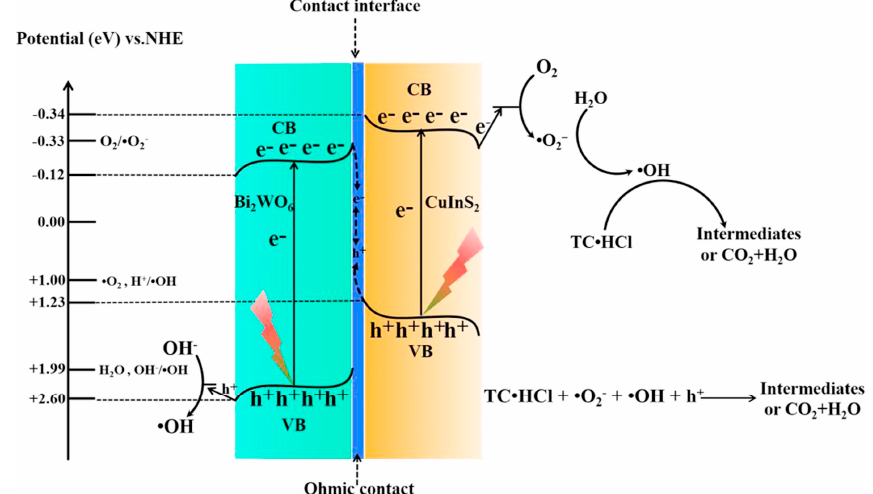
Figure 13. Schematic illustrating the interfacial electron transfer process and possible photocatalytic mechanism of CuInS 2 /Bi 2 WO 6 with the Z-scheme heterojunction. Adapted with permission from Reference [77]. Copyright (2019) Elsevier.